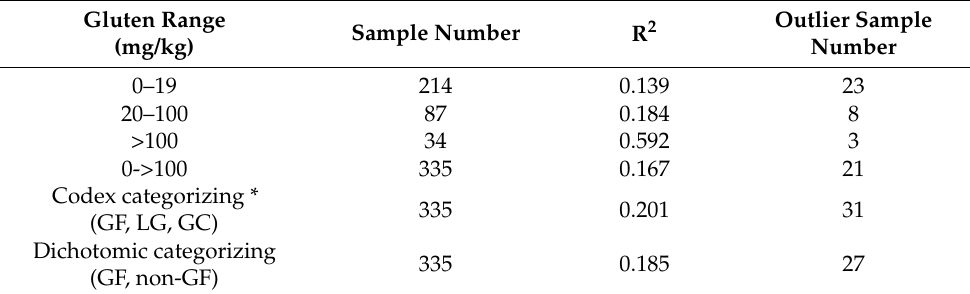
Table 4. Correlation statistics of gluten content or gluten-containing products discrimination of beer determined by R5 competitive enzyme-linked immunosorbent assay and near-infrared analysis in 335